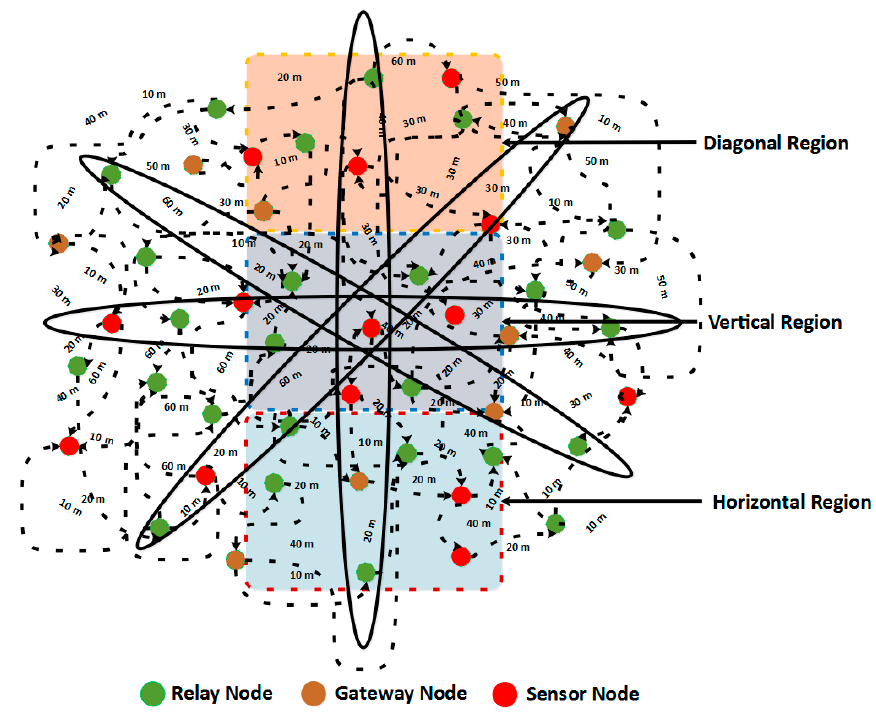
Figure 3. Acoustic Scenario with Path Adjustment of ROBINA.